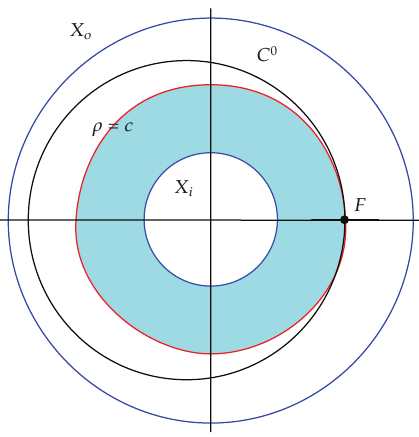
Figure 2: A description of the geometry in Example 2.8. The set C 0 made of the points of the annulus A (cid:5) a,b (cid:6) , where Θ (cid:7) 0, is the union of a closed curve (cid:3) contained in the part of the annulus between ρ (cid:7) c and X o (cid:4) and a small segment (cid:5) c − δ,c (cid:9) δ (cid:6) ×{ 0 } . The function Υ vanishes at ρ (cid:7) a,c,b , and it is negative for a < ρ < c and positive for c < ρ < b (cid:3) we have painted with a darker color the part of the annulus, where Υ < 0 (cid:4) . The point F is the unique fixed point of φ since { F } (cid:7) C 0 ∩ { Υ (cid:7) 0 }